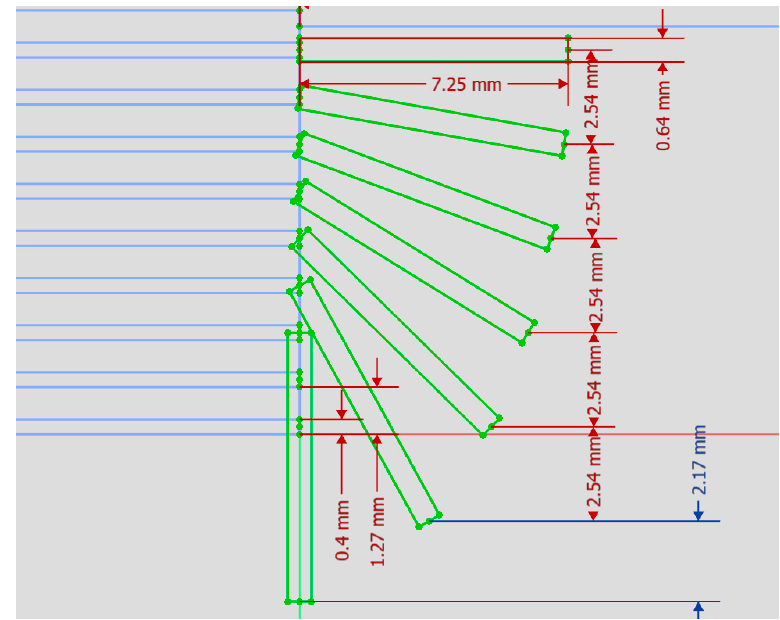
Figure 9. Geometric limitation of the AMBB approach.